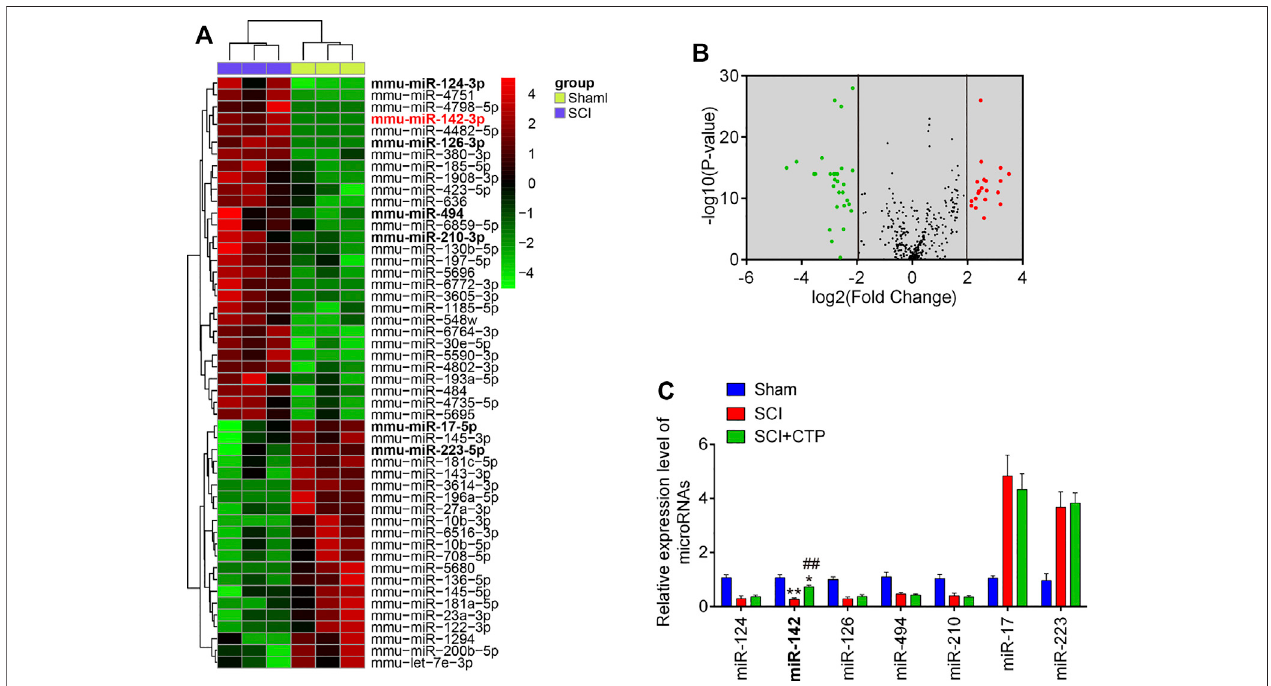
FIGURE3| Catalpolupregulated themiR-142expression in SCI mice. (A) Heatmap ofnormalized expression levels ofmiRNAsinSCI mice and Sham mice (n (cid:1) 3/ group). Microarray dataset was obtained from GEO database and the GEO accession number is GSE19890. Green indicates low expression levels, while red indicates high expression levels. (B) Volcano plot presenting the differentially expressed miRs. Y -axis represents log transformed p -value, and x -axis indicates the mean expression differences of miRs between SCI mice and Sham mice. |log2FoldChange| > 2 was set as the cut-off criteria. (C) The expression levels of miR-124, miR- 142, miR-126, miR-494, miR-210, miR-17 and miR-223 were detected in Sham, SCI, and SCI + CTP groups by qRT-PCR. Data represent the mean ± SD of three independent experiments. * p < 0.05, ** p < 0.01 vs. Sham group; ## p < 0.01 vs. SCI